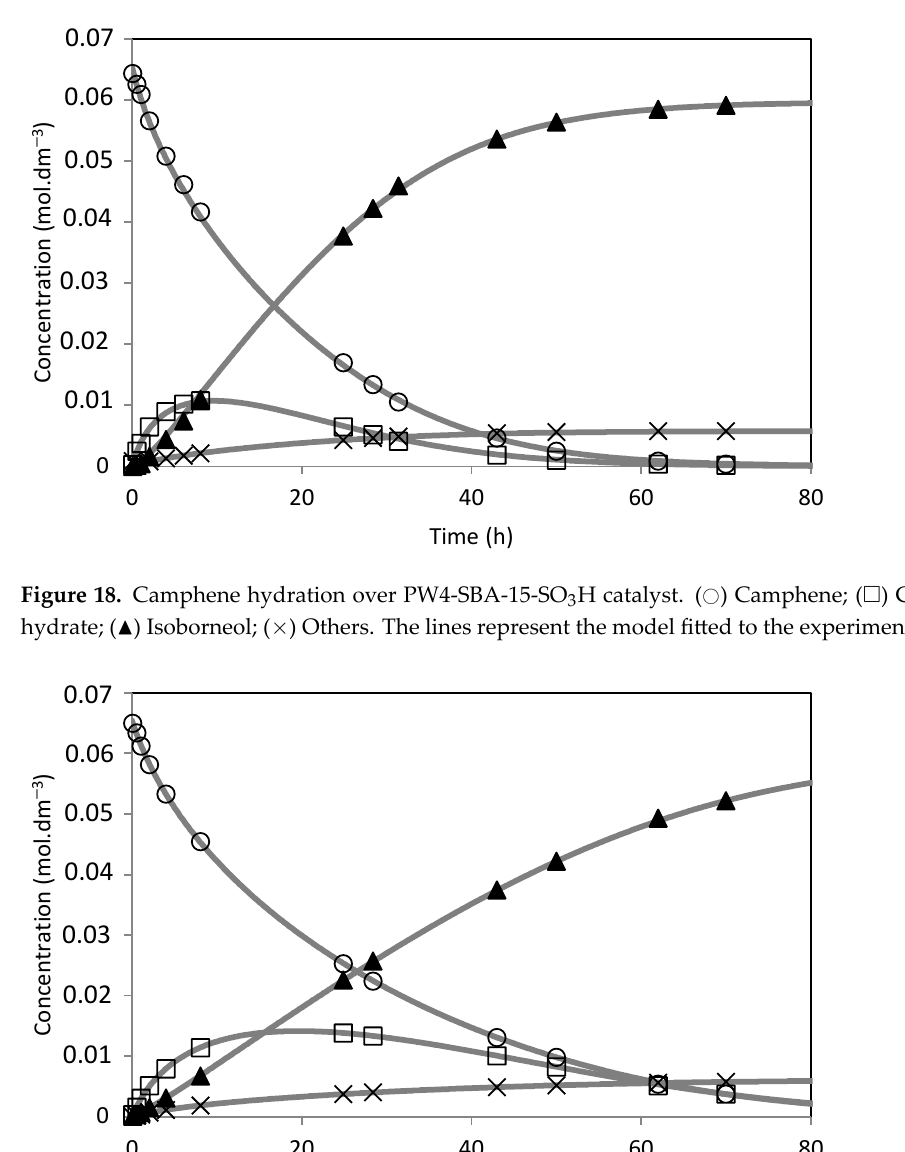
Table 2. Model parameters obtained by fitting the model to experimental data.